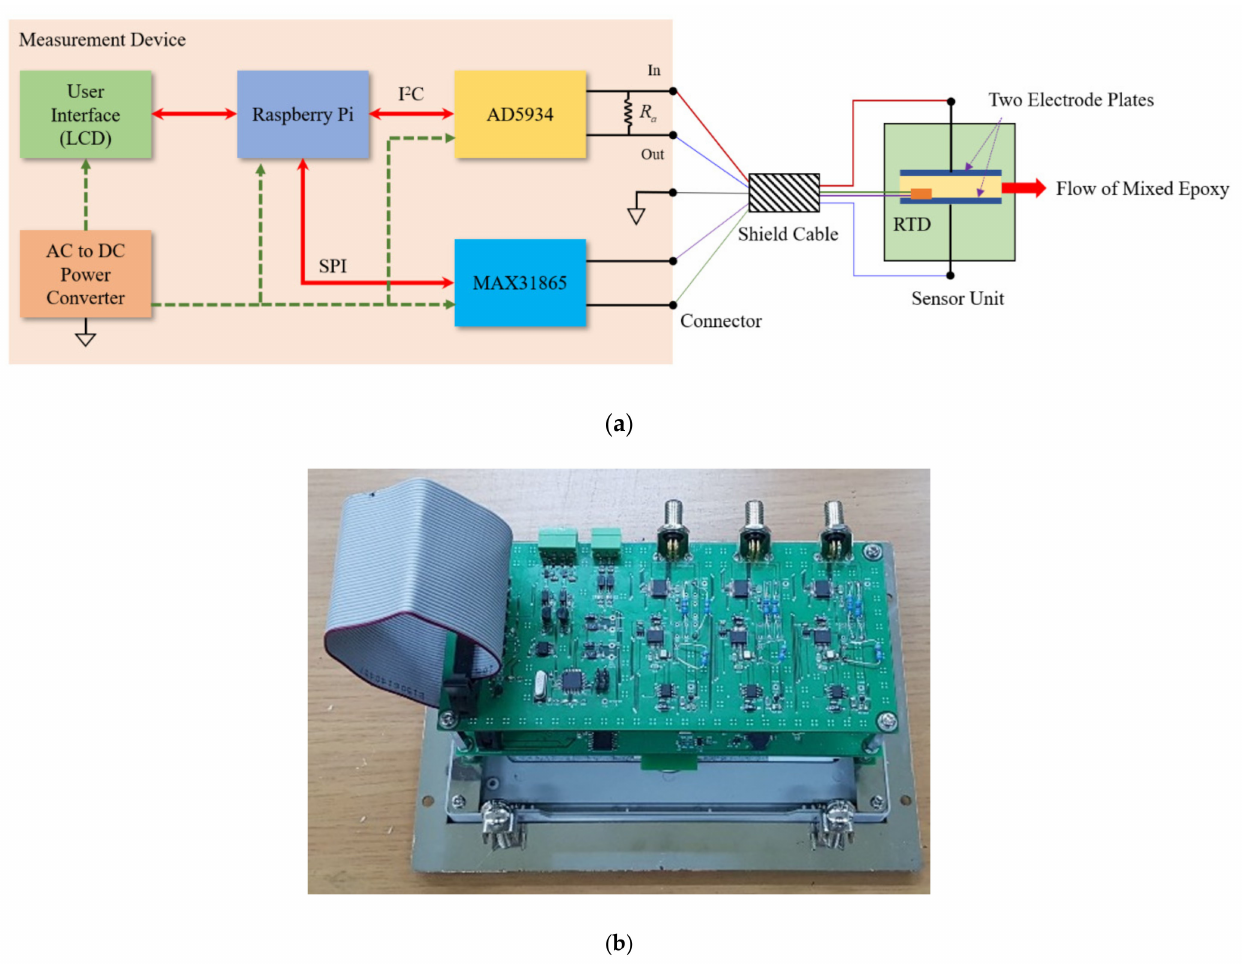
Figure 9. Impedance measurement board with Raspberry Pi: ( a ) Block diagram; ( b ) A picture of the developed